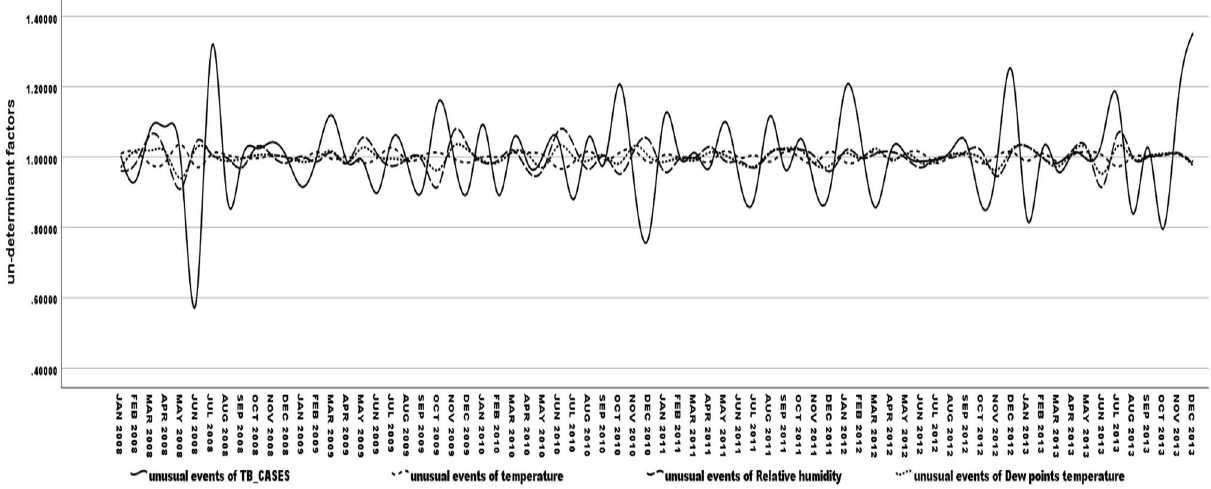
Figure 3. Dew point temperature and temperature influence unusual TB infection in seasons. Method : Individual line chart focusing on climate factors influencing unusual TB infection. Results : Identifying unusual TB infections on seasonal climate factor